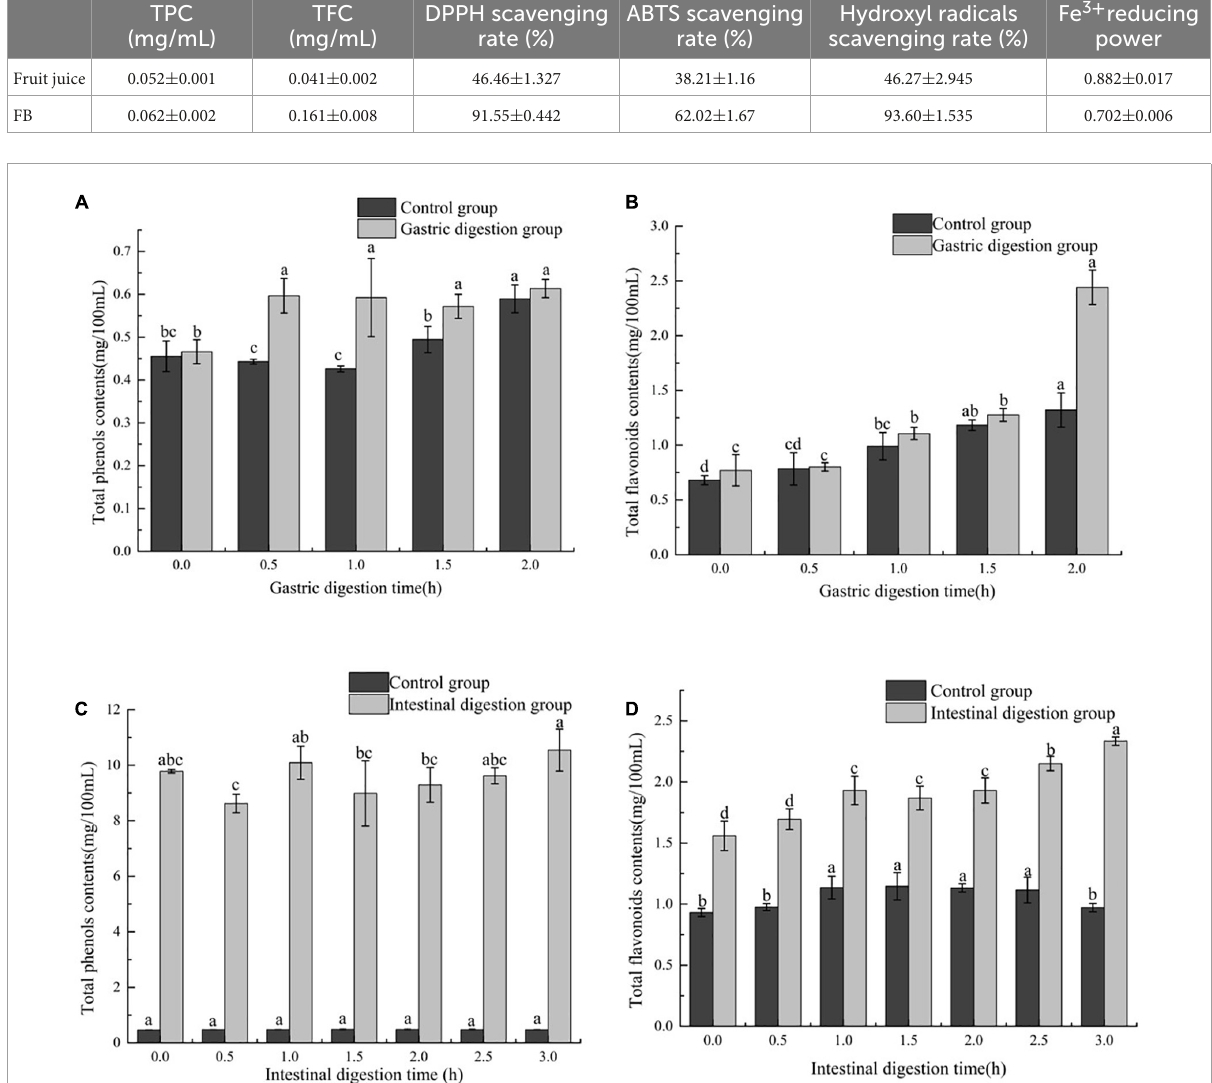
FIGURE1 The effect of in vitro gastrointestinal (GI) digestion on TPC and TFC. (A) The effect of in vitro gastric digestion on TPC, (B) the effect of in vitro gastric digestion on TFC, (C) the effect of in vitro intestinal digestion on TPC, and (D) the effect of in vitro intestinal digestion on TFC. Different lowercase letters indicate significant differences ( p < 0.05), and the same characters are not significantly